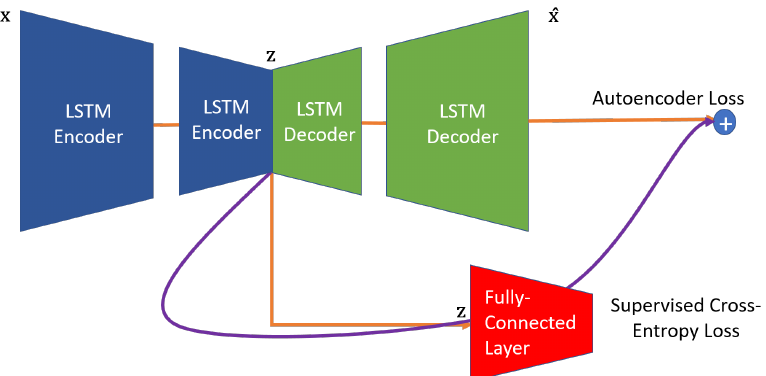
Figure 3. Schematic of a Deep LSTM Supervised Autoencoder Neural Network (DLSTM-SAE